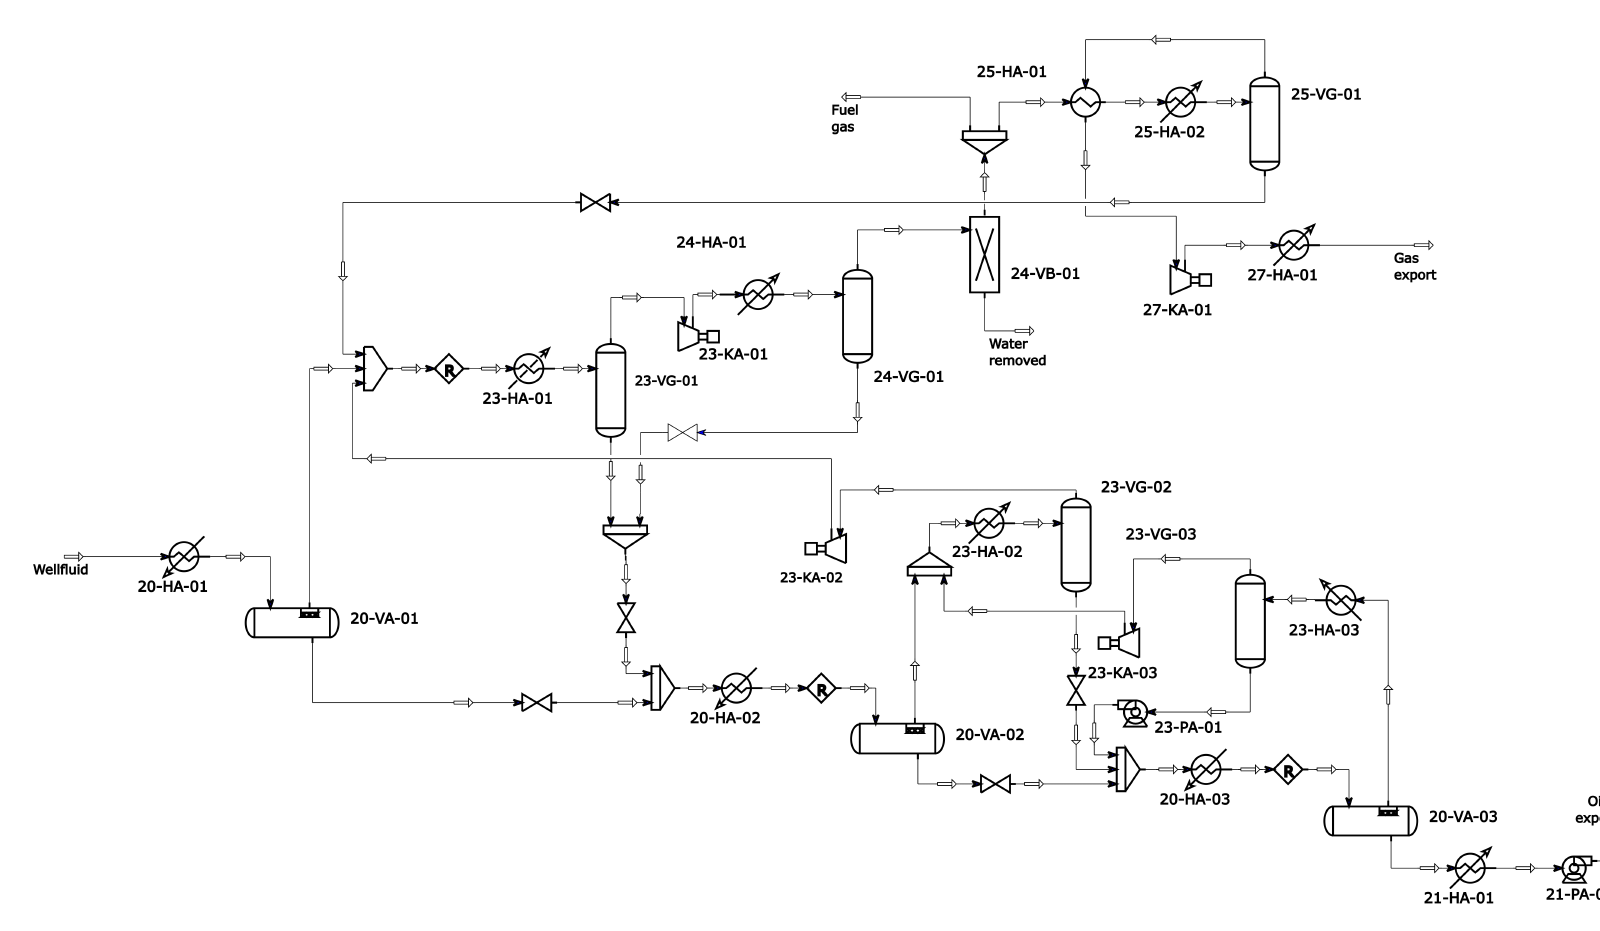
Figure 1. Processflow diagram implemented in the process simulator flow